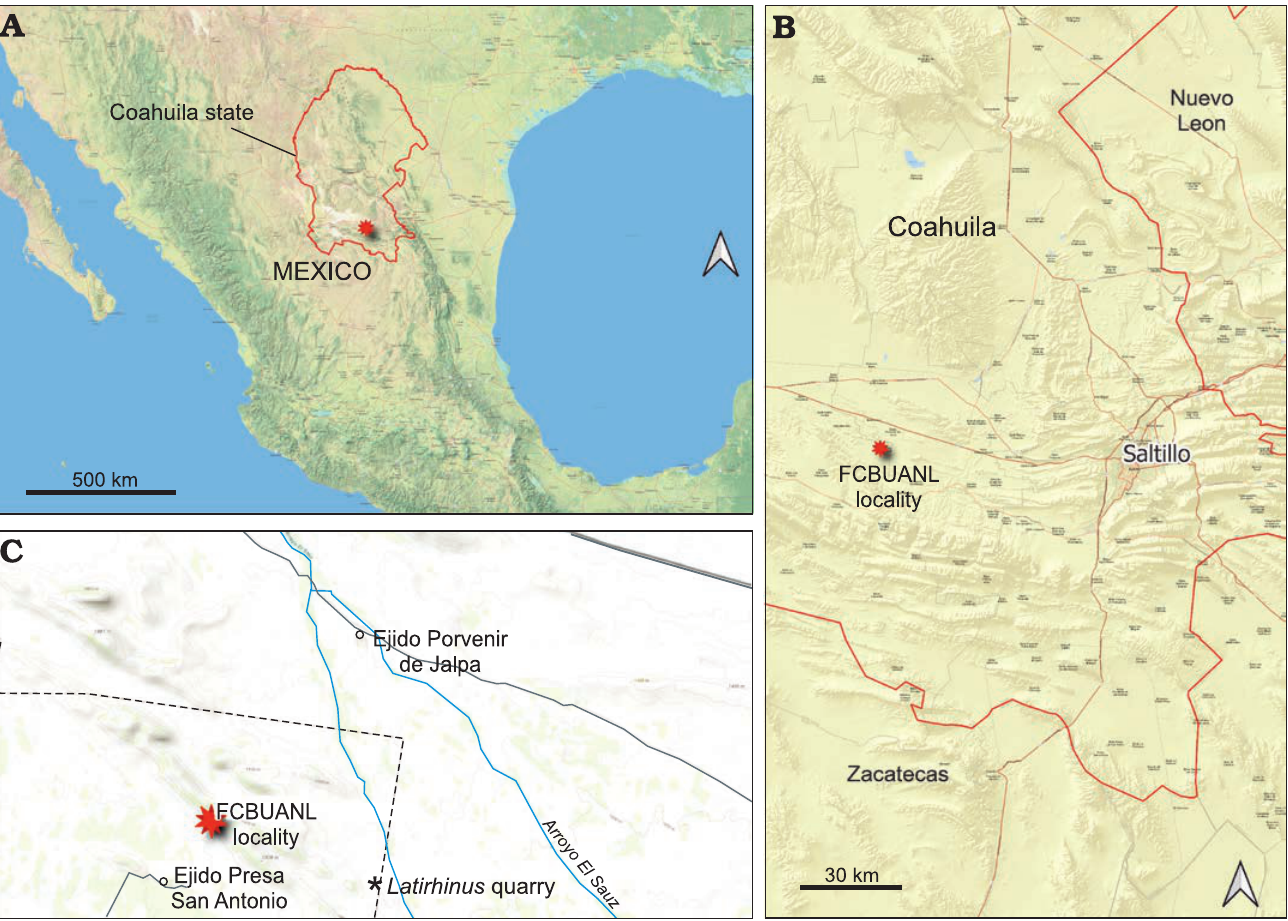
Fig. 1. Map showing location of the Coahuila state ( A ) and FCBUANL locality ( B ) where studied fossils were found. Detailed map indicating the principal localities of Cerro del Pueblo Formation ( C ), FCBUANL_2711 locality represented by red